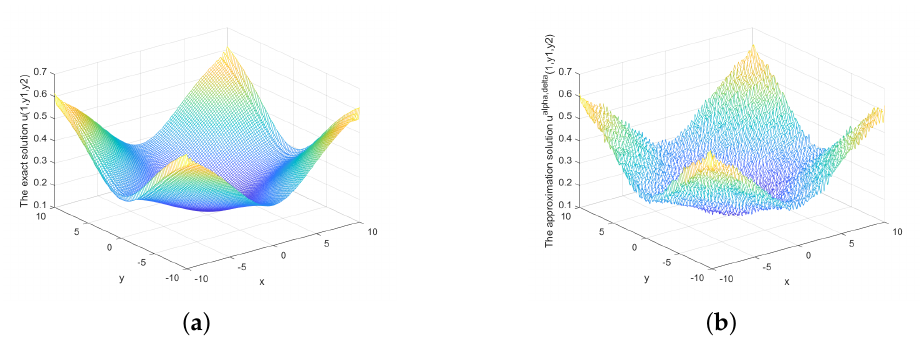
Figure 15. ( a ) The exact solution and ( b ) the regularized solution when x = 0.3, δ = 1 × 10 − 4 under posterior rule.